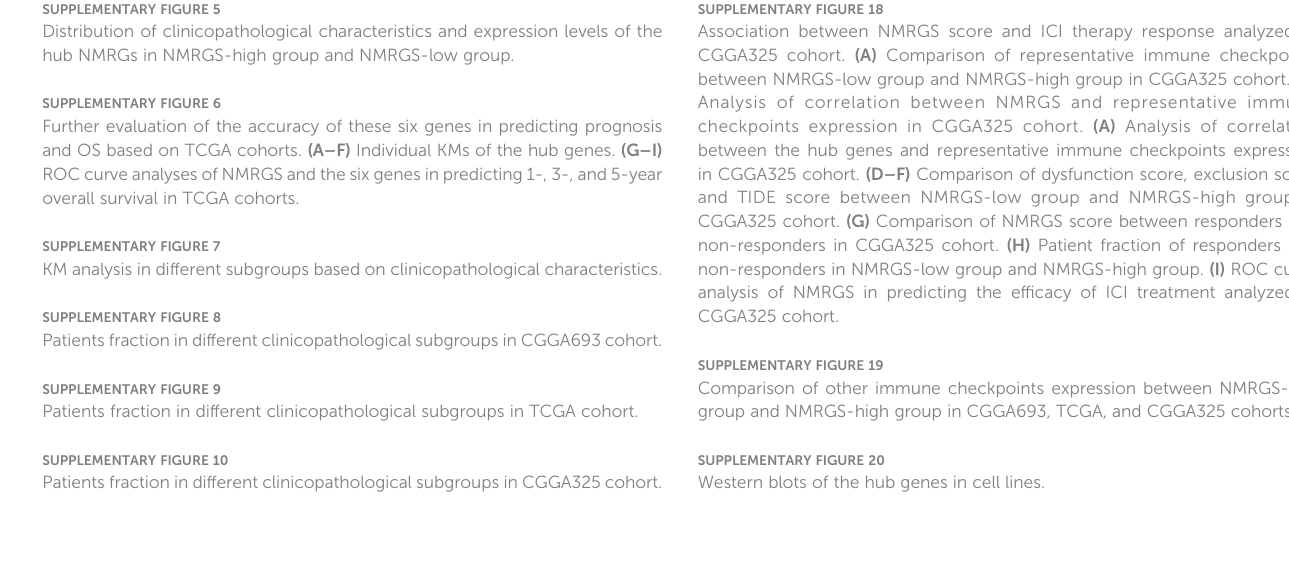
SUPPLEMENTARY FIGURE 3 Kaplan – Meier curve analyses of the NAD+ metabolism-related genes. SUPPLEMENTARY FIGURE 4 Lasso regression of the six hub genes. (A) Tuning parameter( l ) in LASSO model using cross-validation. (B) The LASSO coef fi cient pro fi le of 6 NMRGs.